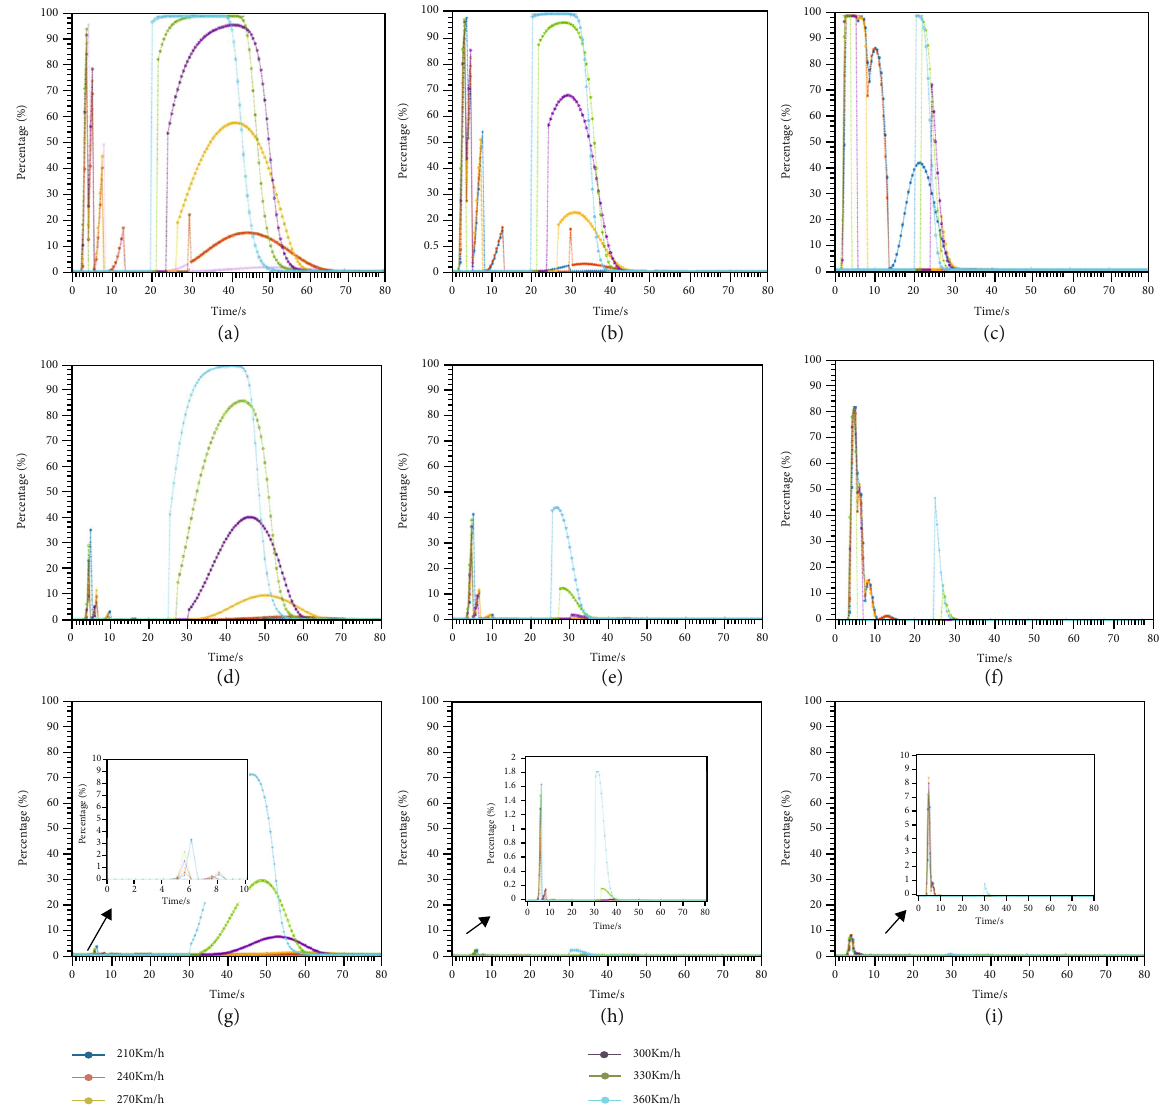
∈ ½ 210 Km/h, 360 Km/h (cid:2) , MAV